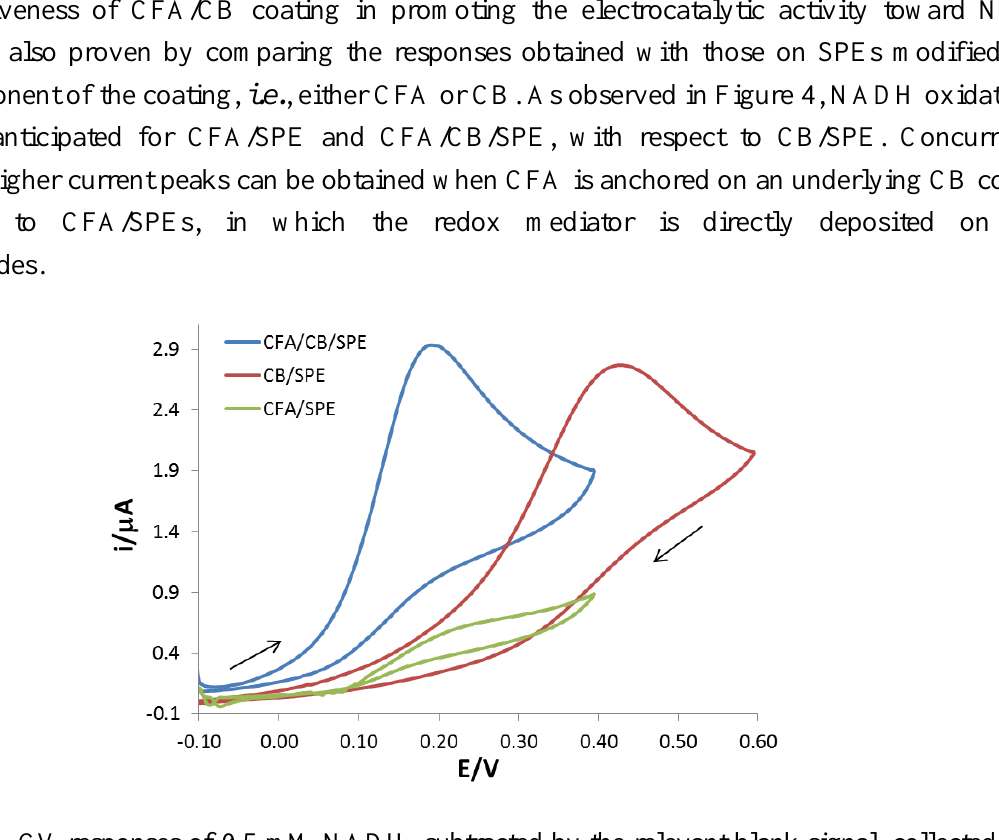
Figure 4. CV responses of 0.5 mM NADH, subtracted by the relevant blank signal, collected in 0.1 M PB (pH 7.0), 0.1 M KCl at the different modified